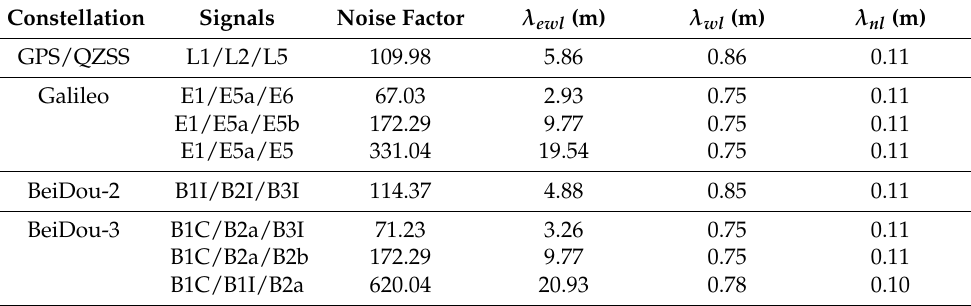
Table 1. GPS, Galileo, and BeiDou-2/3 signal combinations used to form ionosphere-free wide- lane observables. Noise amplification factors are given in the third column. The wavelengths of (extra-)wide-lane and narrow-lane ambiguities are listed in the last three columns. Constellation